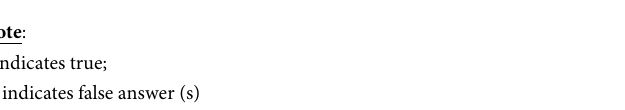
Table 2. Frequency of respondents towards knowledge indicators about COVID-19 among secondary school stu- dents in Gondar town, Northwest Ethiopia, 2021. Indicators Yes N Is COVID -19 a curable disease?